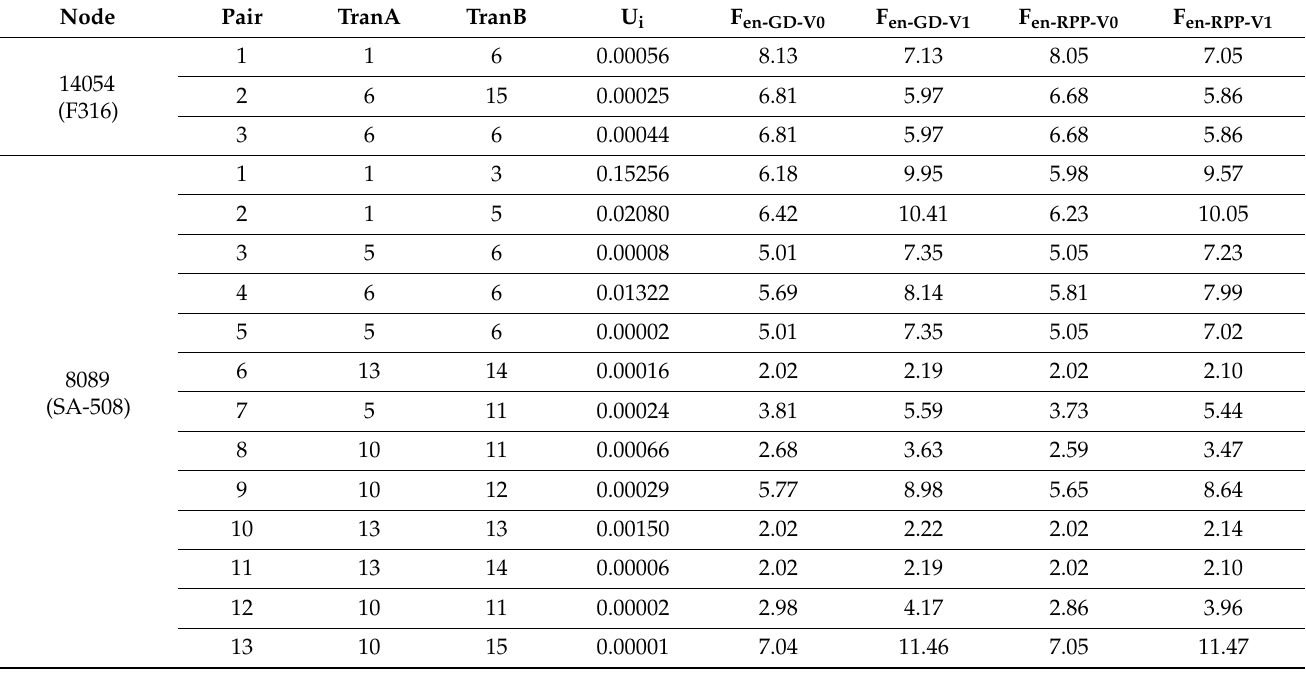
Table 6. Fatigue usage factor in air and the F en value of RPV inlet